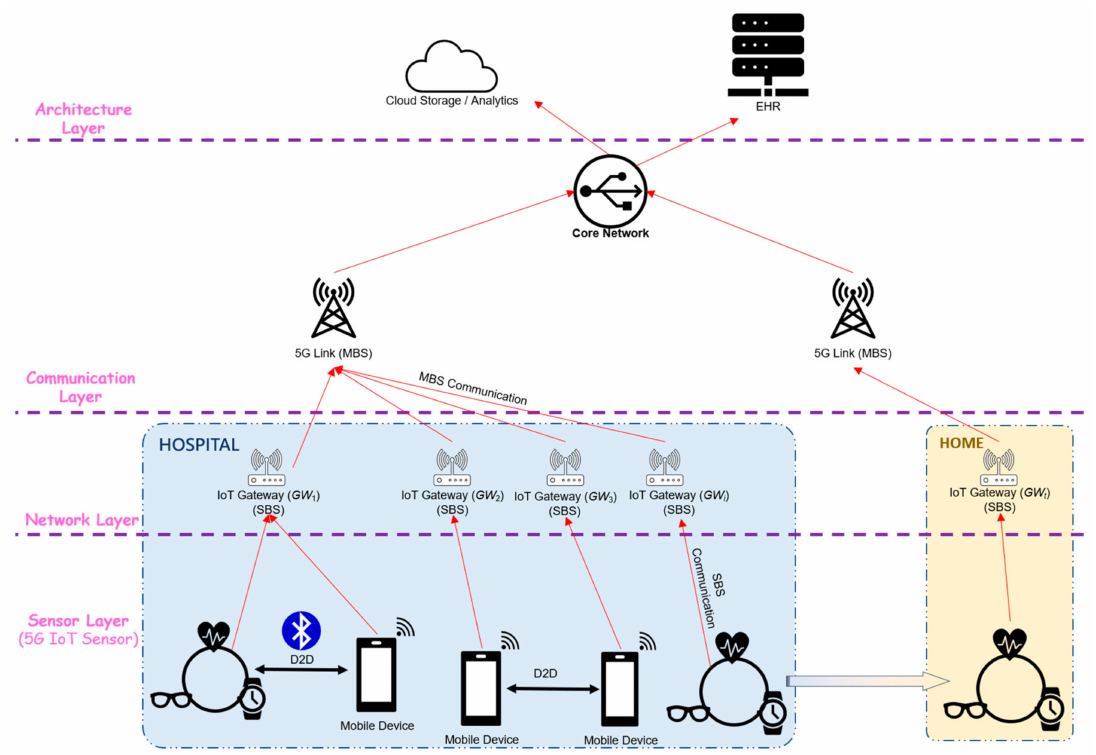
Figure 2. System structure of proposed